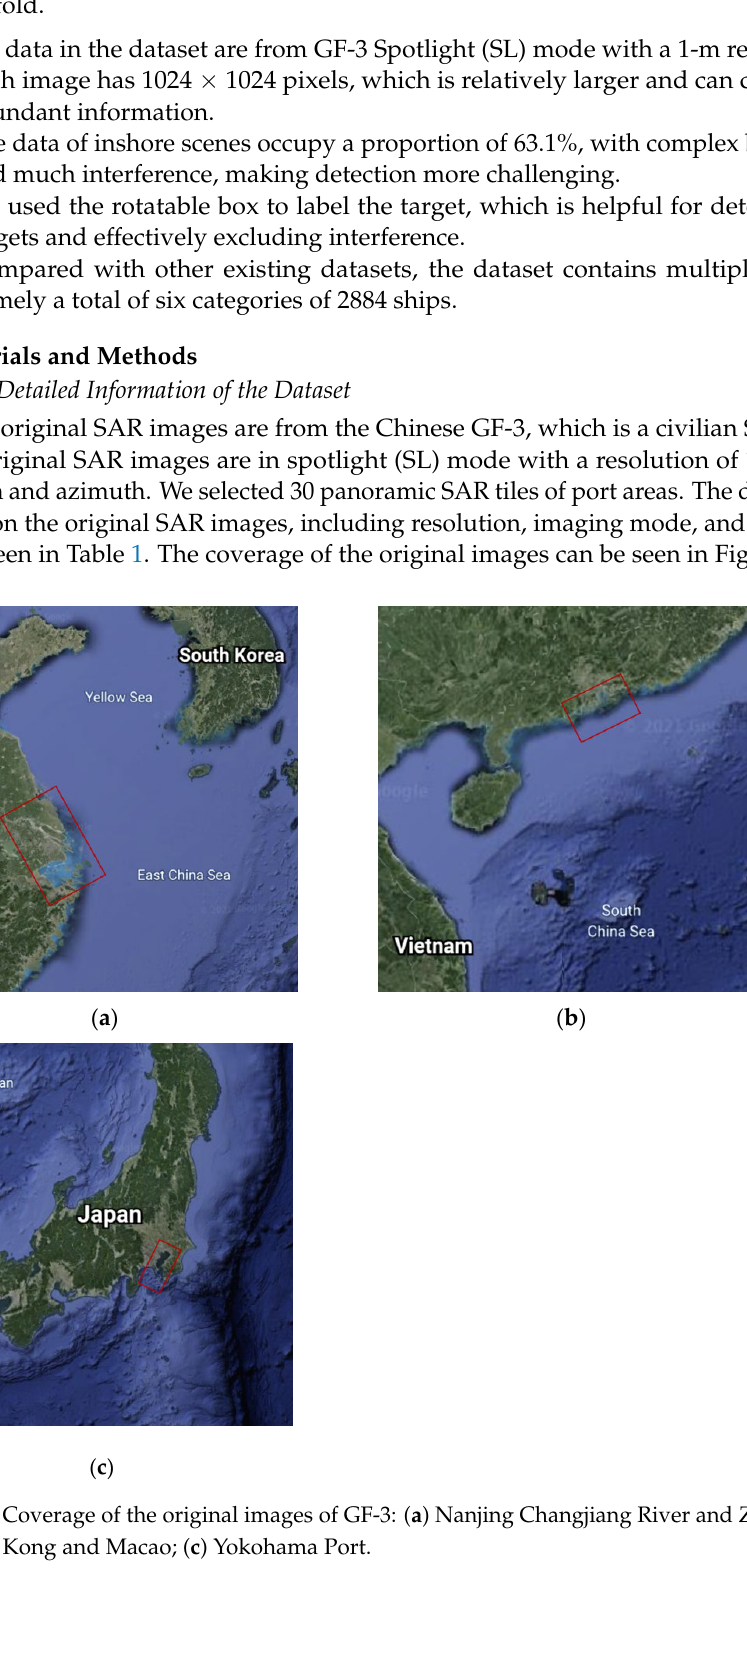
( b ) Figure 2. Comparison of the horizontal box and the rotatable box: ( a ) horizontal box; ( b ) rotatable box. The slice generation method selects an area with ships in the wider picture for inter- ception, and the image size is set to 1024 × 1024. Some representative SAR slices in the dataset are shown in Figure 3. After slice production was completed, we started to label the slice. The labeling tool is a set of development tools for rotating frame labeling devel- oped by our laboratory based on OpenCV. We used optical images to assist to label